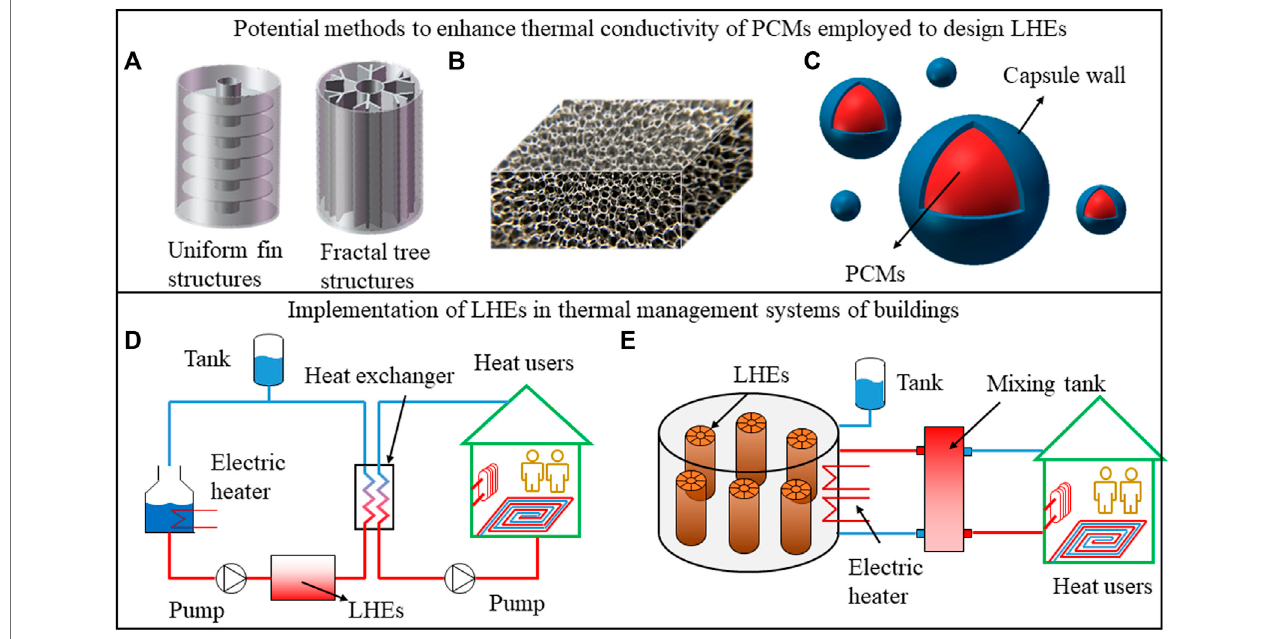
FIGURE 1 | Potential thermal conductivity enhancers including (A) Metallic fi ns (Huang et al., 2021), (B) Metallic foams (Zhang et al., 2020) (C) Microcapsules. Schematic diagram of implementation of LHEs (latent heat-based heater exchangers) in (D) Independent electric heater (Zhao et al., 2020) and (E) Integrated electric heater based thermal management systems of buildings (Zhao et al.,